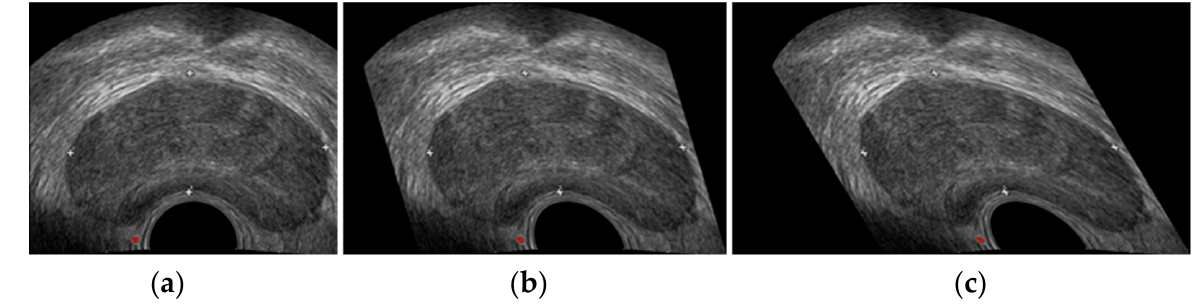
Figure 4. Effect diagram of shear transformation. ( a ) is the original image, ( b ) shows the shear transformation with a transverse parameter of 0.3, ( c ) shows the shear transformation with a transverse parameter of 0.6).